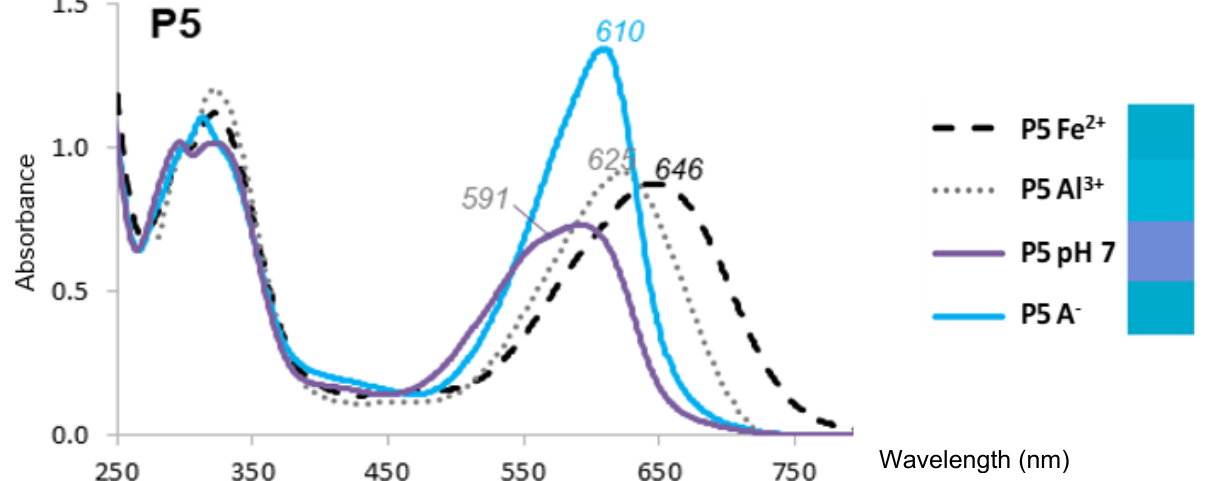
Figure 1. UV-VIS spectra of Pigment 5 (50 µM) at pH 7, its pure anionic base (A − , calculated), and its Fe 2+ and Al 3+ complexes (1 equiv.). Right: color patches from the L*a*b* coordinates calculated from the visible spectra.